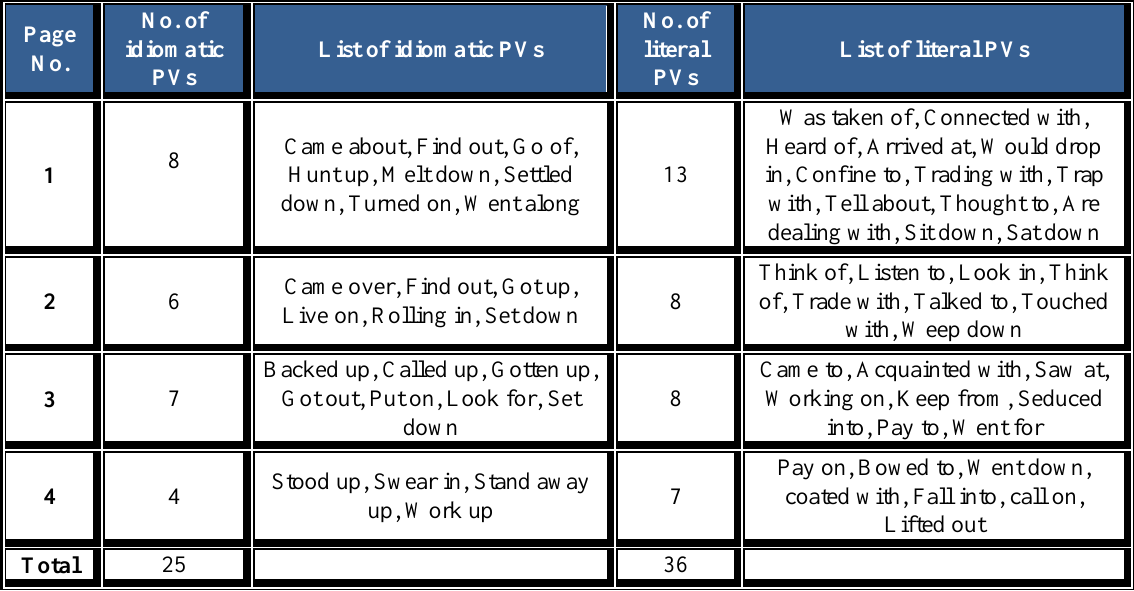
List of literal PVs